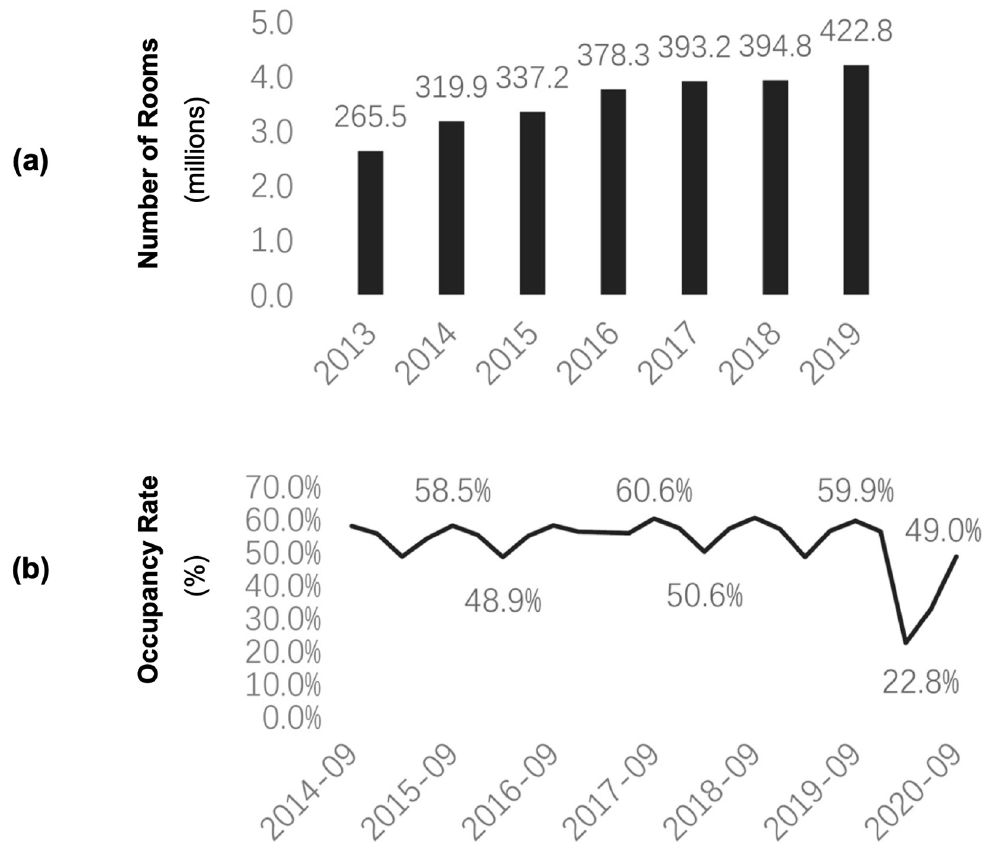
Figure 6. ( a ) Number of rooms in the accommodation sector in China from 2013 to 2019, and ( b ) occupancy rate of star-rated hotels in China from 2014 to 2020 Q3.